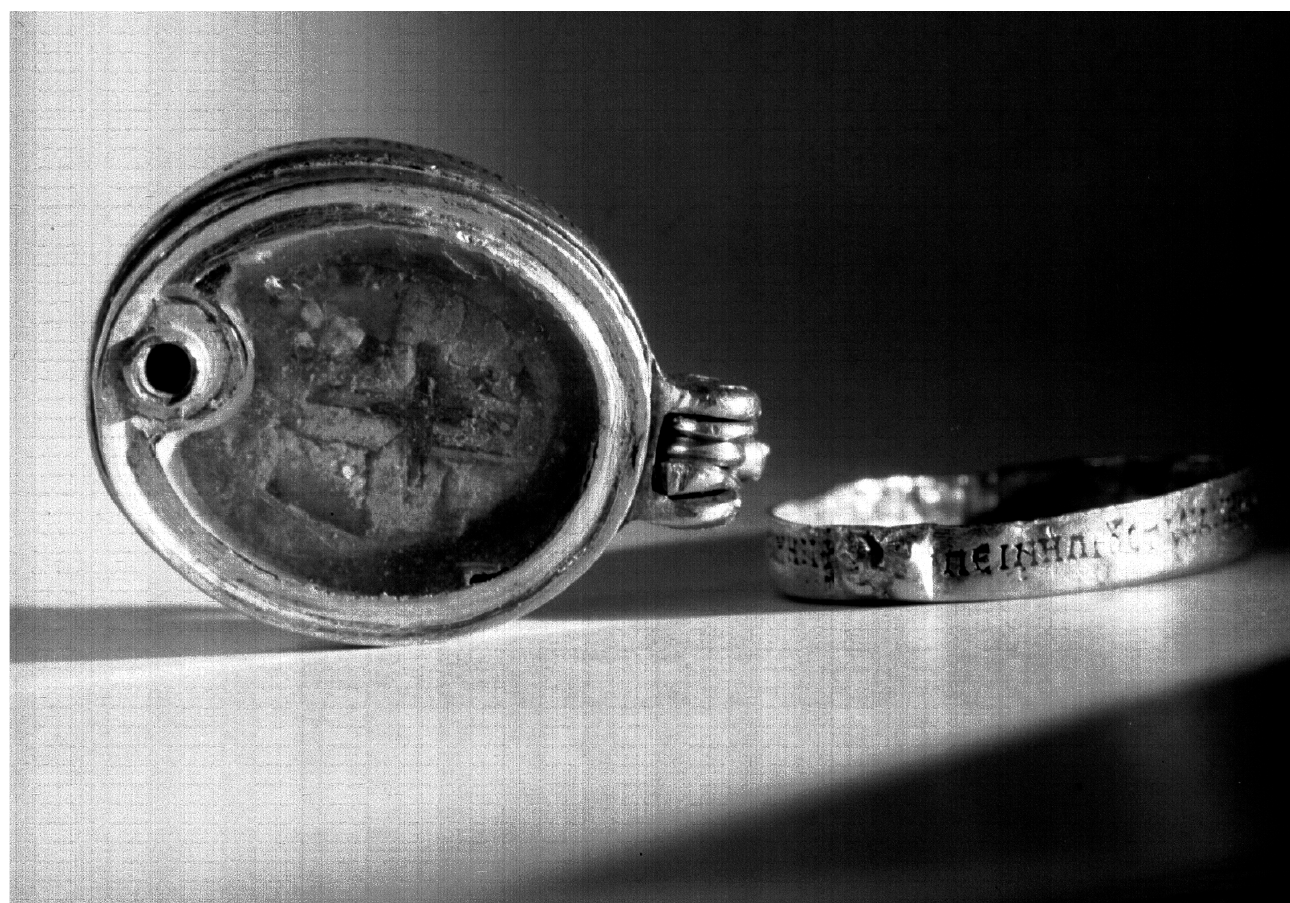
Figure 5. Inner reliquary capsule associated with the sainte Vertu, silver gilt, niello and enamel, Byzantine, eleventh century or earlier, treasury of the abbey Saint-Sauveur de Charroux (Photo by permission: Ferron © Ministère de la Culture, Médiathèque du patrimoine et de la photographie, diffusion. RMN-GP).